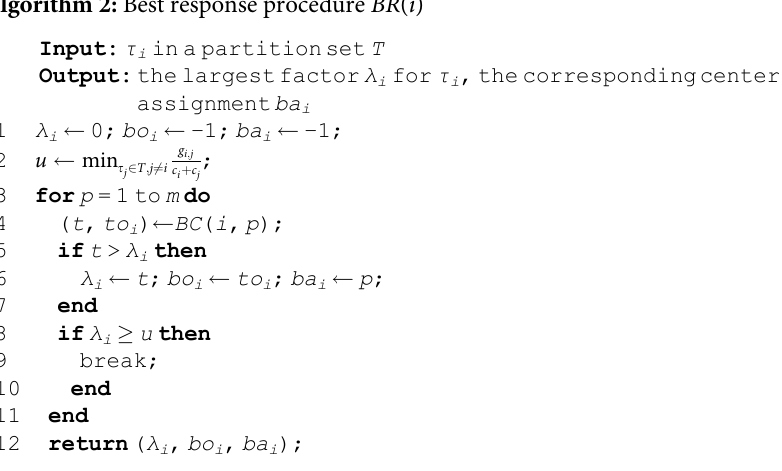
Algorithm 2: Best response procedure BR ( i